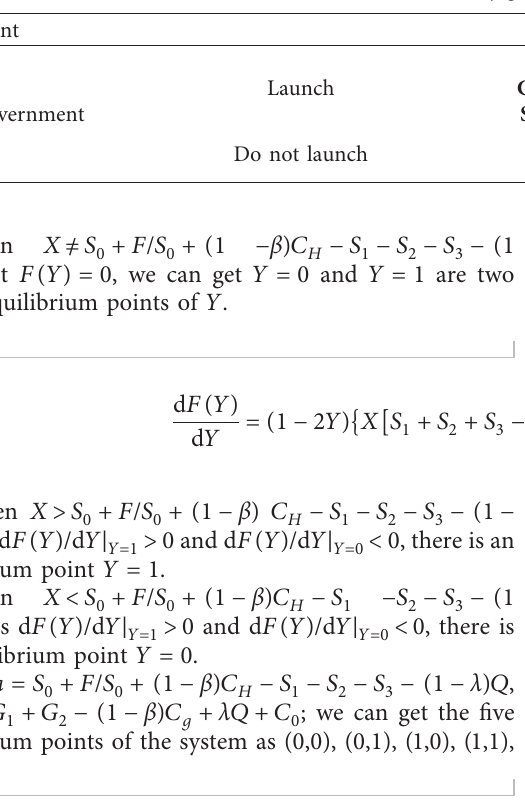
Table 5: Benefit matrix of the evolutionary game between local government and social